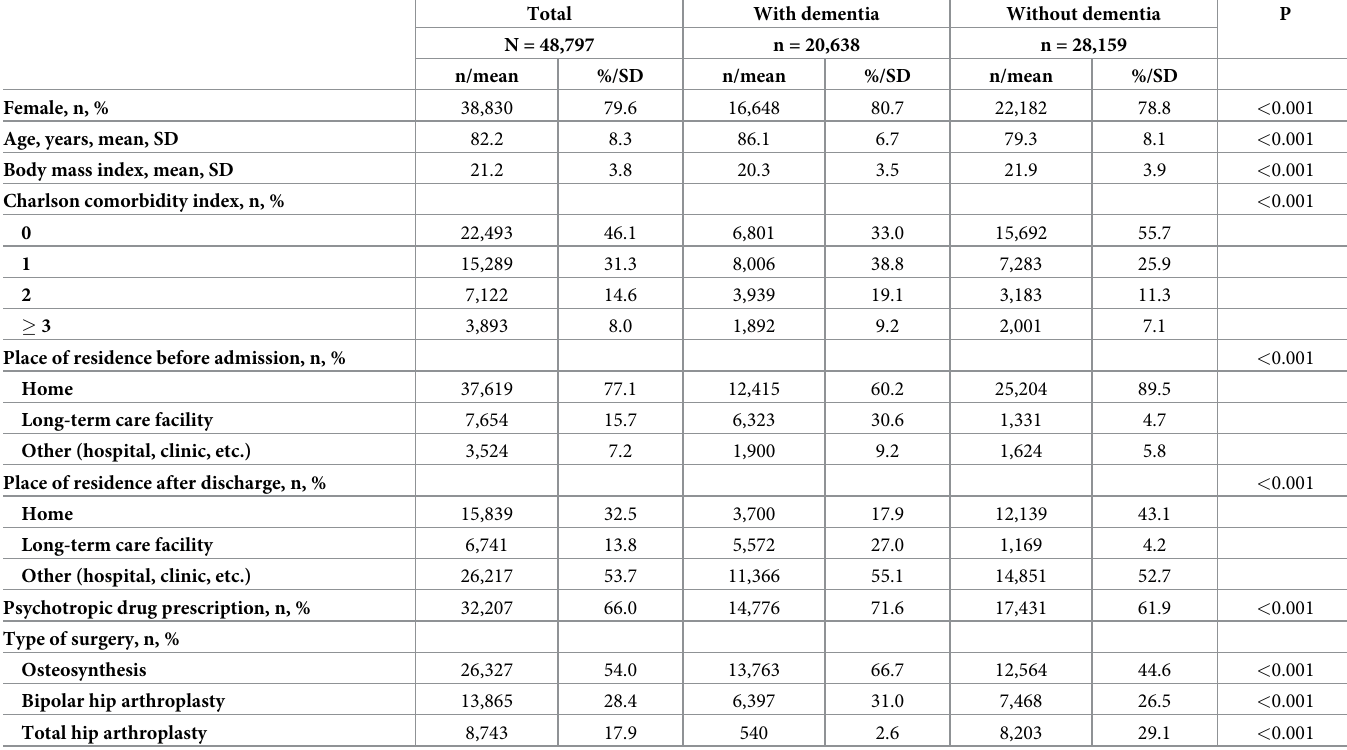
Table 1. Characteristics of the study population with and without dementia.